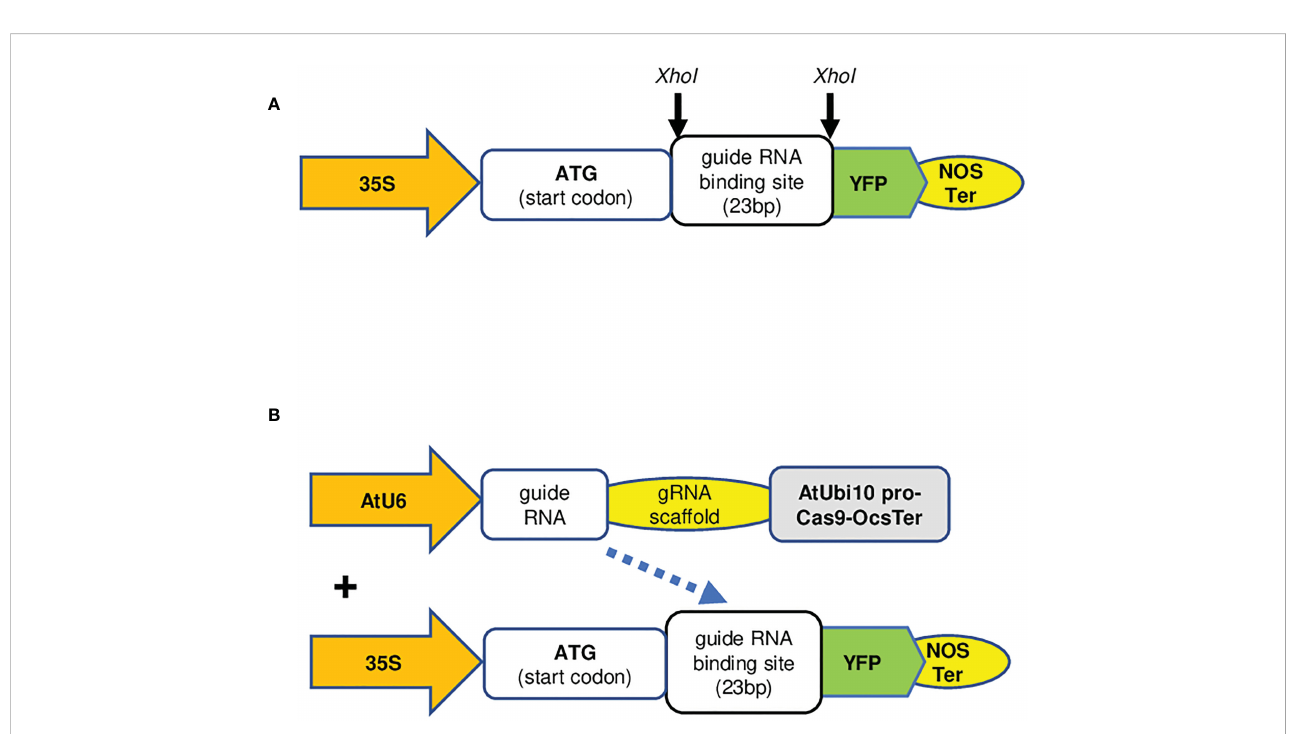
FIGURE 3 The key elements of the plasmid vectors used in this study. (A) The scheme of pgRNA-YFP vector. Two sequence complementary oligonucleotide primers of a given gRNA binding sequence (23 nt), including a PAM site, can be synthesized, annealed, and cloned to the Xho I sites of p Xho I-ccdB-YFP via Gibson cloning. 35S; Cauli fl ower mosaic virus 35S promoter, YFP; yellow fl uorescent protein, Nos Ter; Agrobacterium tumefaciens nopaline synthase terminator. Other key elements are identical to the original pEALEYGATE 101 vector [14]. (B) The scheme of pCas9-GOI-gRNA and pgRNA-YFP, illustrates that pCas9-AtU6pro-gRNA expressing gRNA targets the YFP gene in the pgRNA-YFP construct. AtU6, Arabidopsis U6 promoter; AtUbi10 pro, Arabidopsis ubiquitin 10 promoter; OCS Ter, Agrobacterium tumefaciens octopine synthase gene terminator; PAM, protospacer adjacent motif.